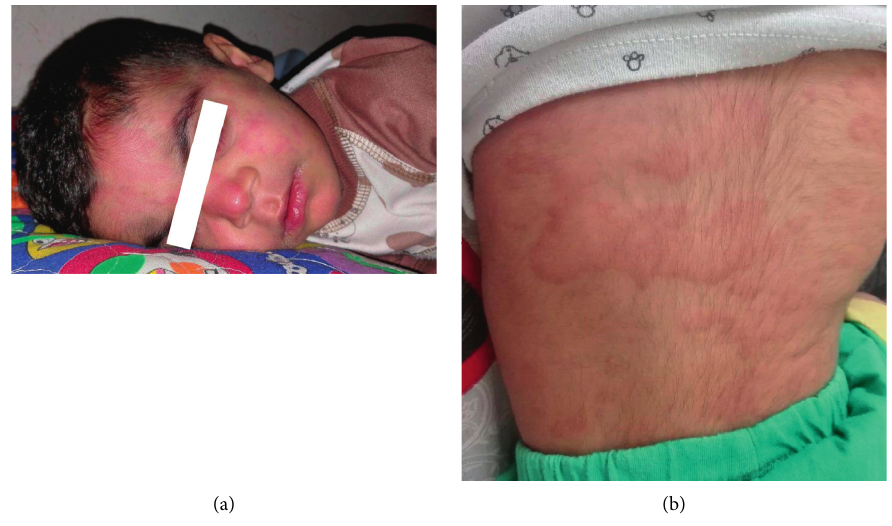
Figure 1: Urticaria-like rash on the face (a) and trunk